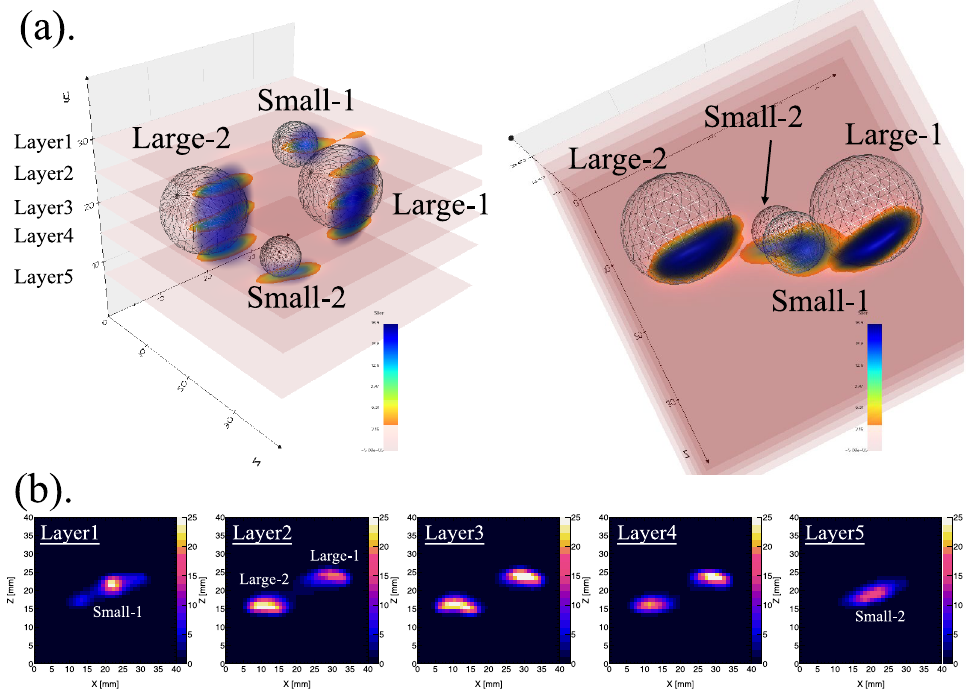
Figure 4. ( a ) Reconstructed three-dimensional (3D) phantom. ( b ) Tomographic images at four different layers perpendicular to the y-axis.